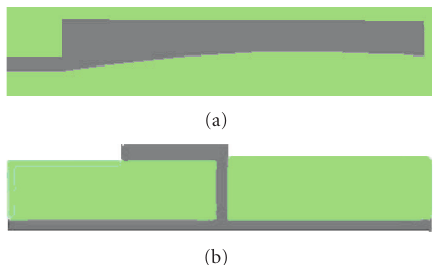
Figure 3: (a) Layout of half tapered LWA. (b) Cross-section of half LWA.